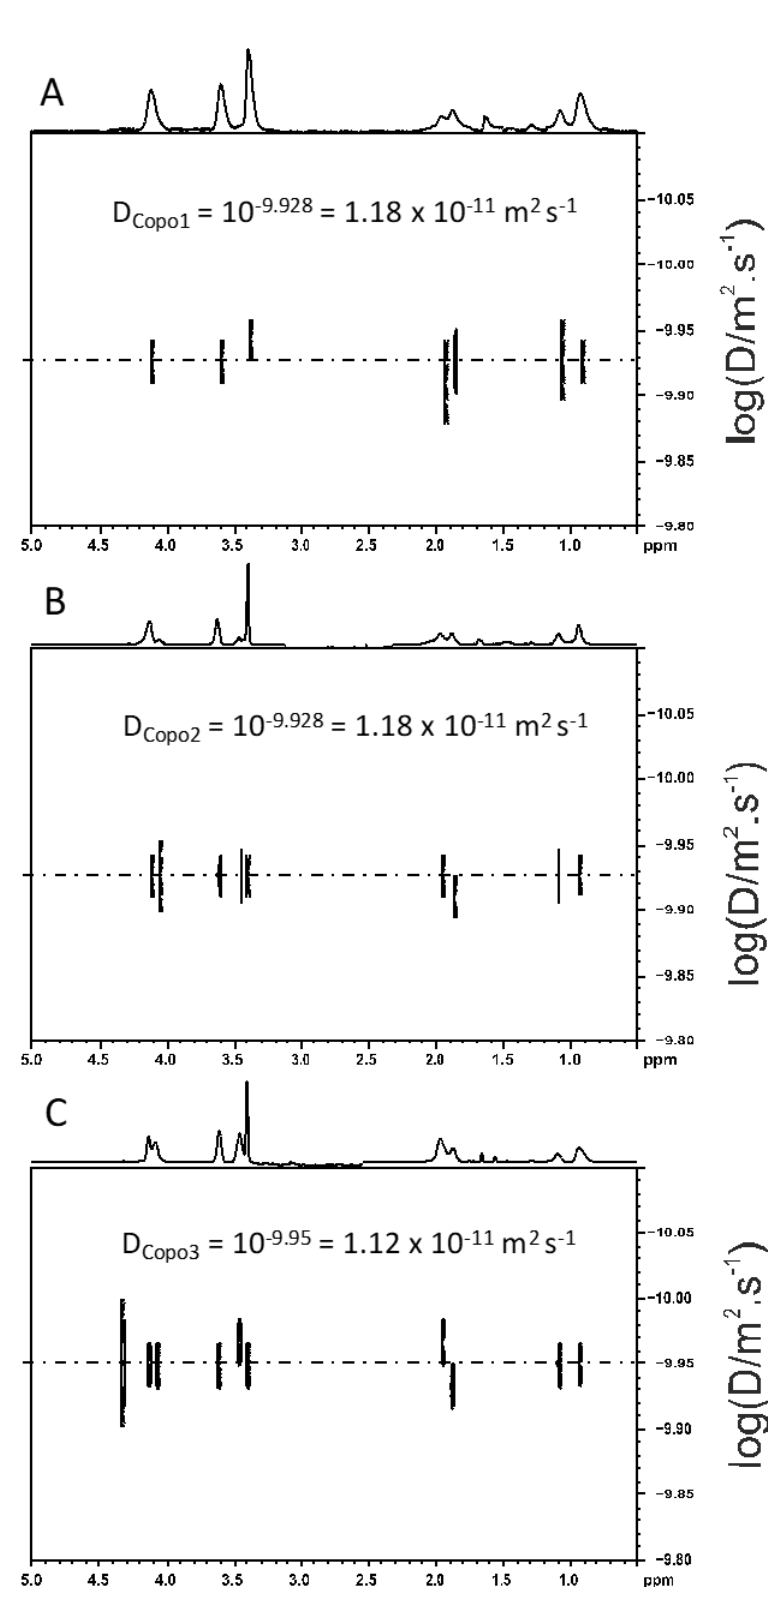
Figure 5. DOSY NMR of copolymers: ( A ) Copo1, ( B ) Copo2 and ( C )